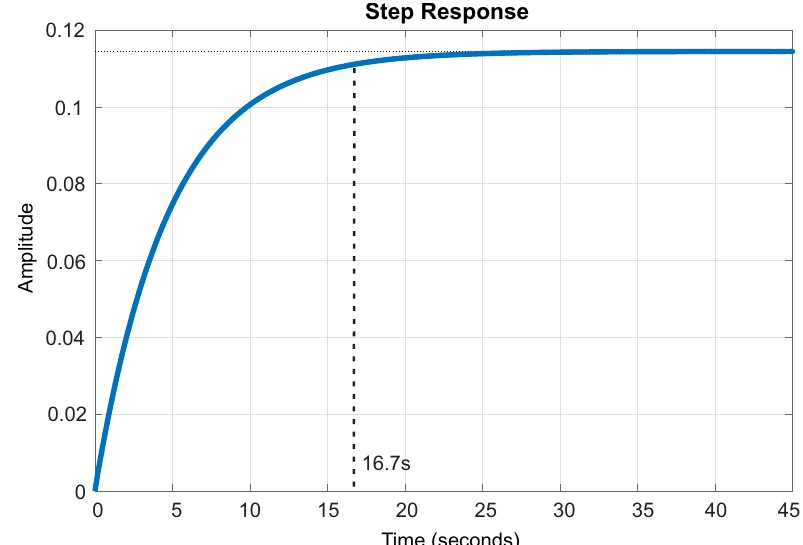
Figure 9. Step response of the experimental system.